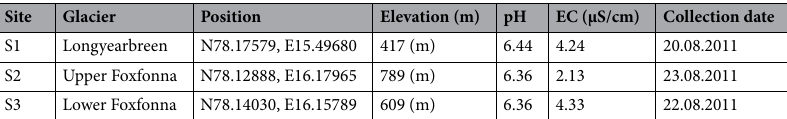
Table 1. Locations of the sampling sites with pH and electrical conductivity